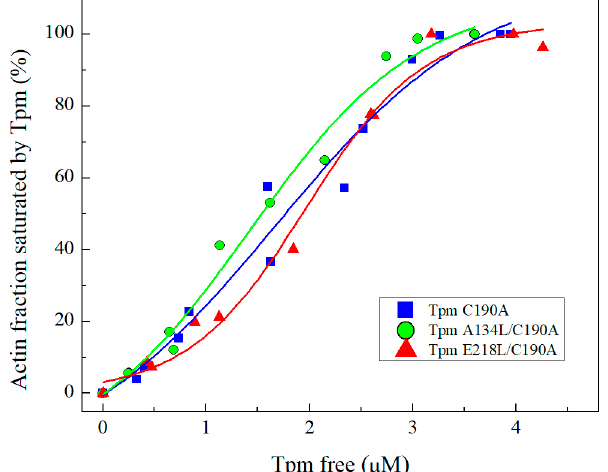
Figure 3. The a ffi nity of Tpm species A134L / C190A, E218L / C190A, and control C190A Tpm for F-actin determined by co-sedimentation assay. The Tpm concentration of F-actin half-saturation (K 50% ) was 1.42 ± 0.18 µ M for A134L / C190A, 1.96 ± 0.11 µ M for E218L / C190A, and 1.68 ± 0.32 µ M for C190A Tpm species. The K 50% values are the average ± SD for three experiments. All experimental points were plotted.